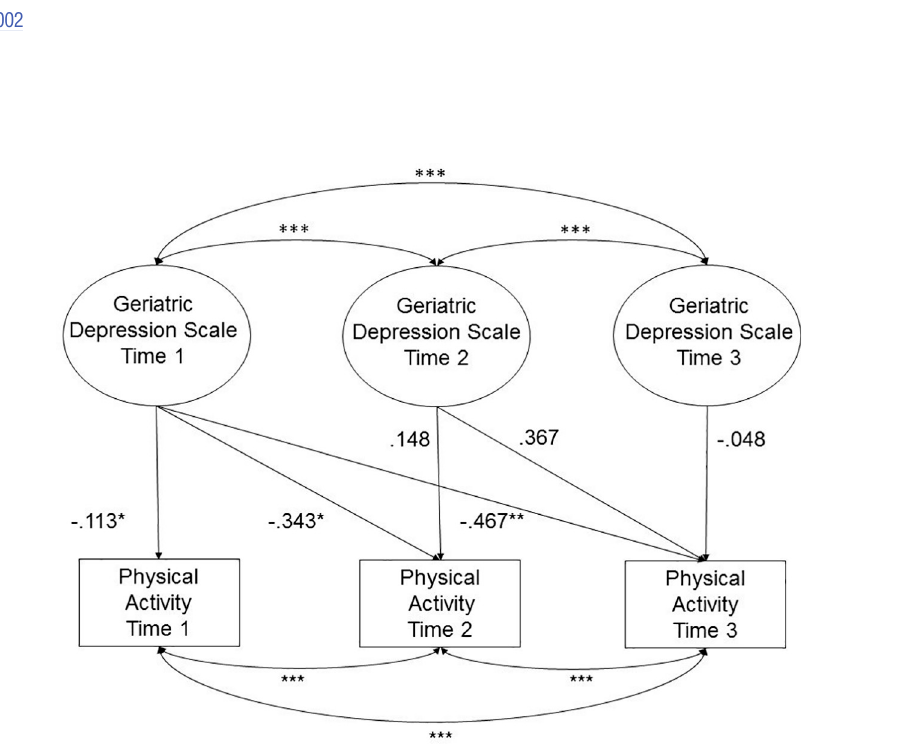
Fig 1. Geriatric depression scale predicts physical activity adjusting for age, sex, education, BMI, CDR, neuropsychiatric medications. Presented in standardized estimates. � p < .05, �� p < .01, ��� p <